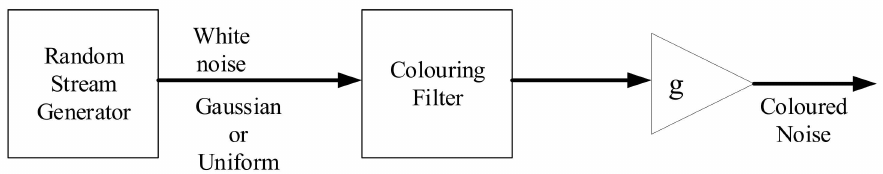
Figure 4. Process of generating colored